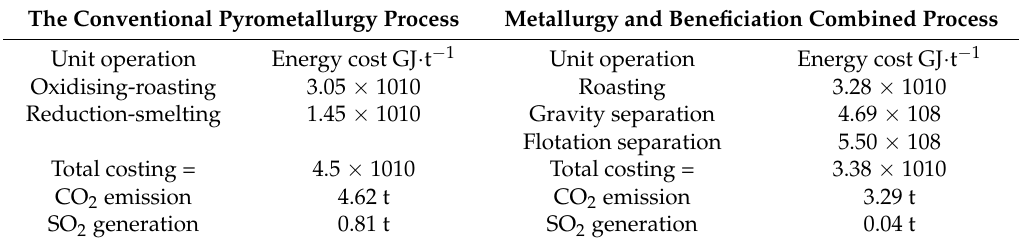
Table 3. The standard energy consumption to produce 1t of antimony by the current pyrometallurgy process and this metallurgy and beneficiation combined process via the present